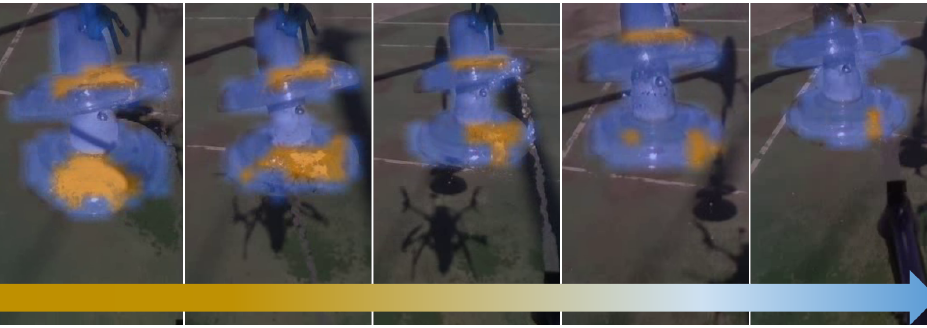
Figure 14. Evolution of soiled areas in the insulator.